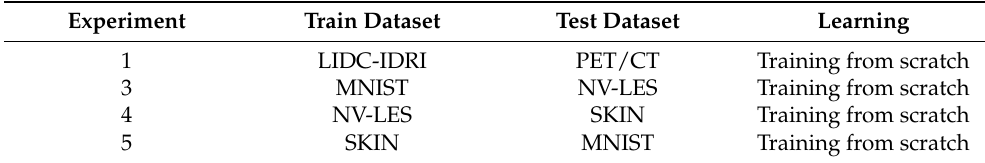
Table 4. Experiment setups for evaluating the models’ robustness to image device variation.